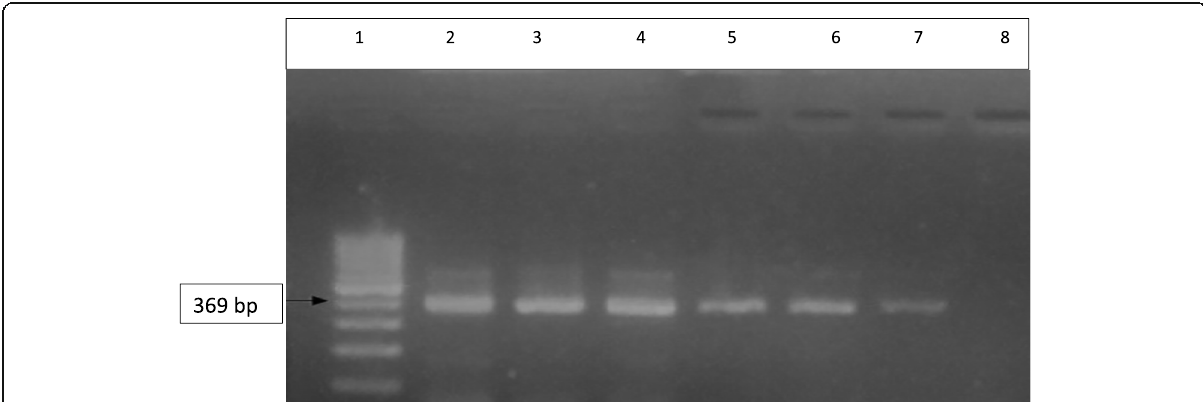
Fig. 1 Agarose gel electrophoresis of amplified product AME gene generated by PCR assay. Lane 1: molecular weight marker (ladder 100 bp); lane (2 – 7): aac (6 ′ )-Ie-aph(2 ″ )-Ia positive (369 bp). Lane 8: negative control